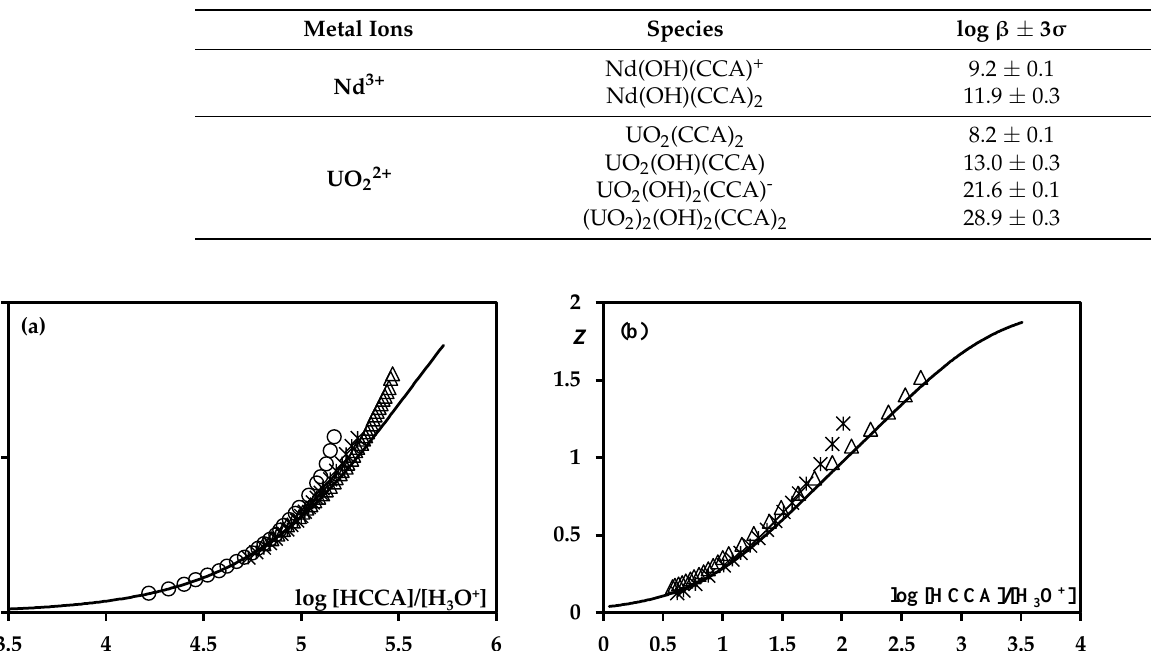
Figure 2. Z as a function of log([HCCA]/[H 3 O + ]) for ( a ) Nd 3+ -HCCA and ( b ) UO 22+ -HCCA systems. Triangles (0.5, 5); diamond (5, 5); circles (1, 2). The curve was calculated with the constants obtained by numerical treatment and reported in